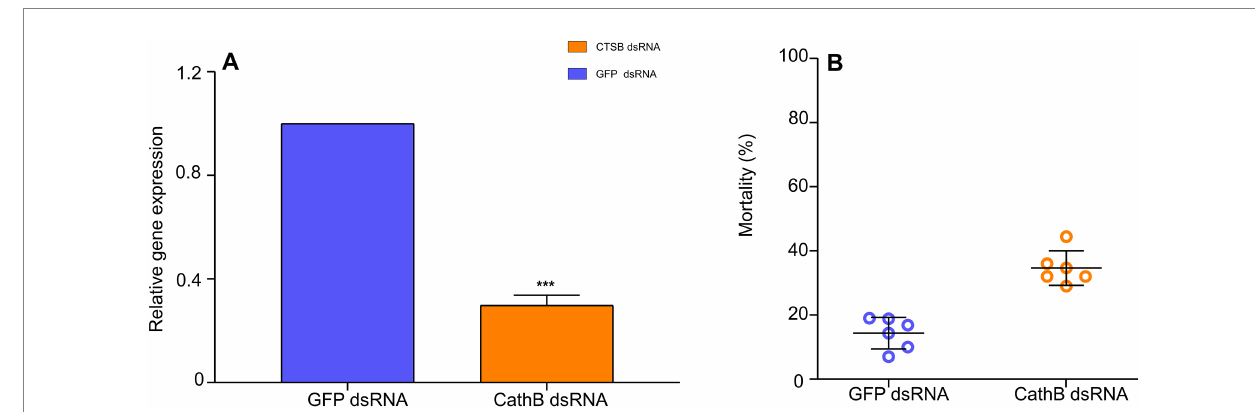
FIGURE 7 The effect of dsRNAs treatment on B. tabaci MED. (A) The relative gene expression of cathepsin B on B. tabaci MED of dsRNAs treatment. (B) The mortality effect on B. tabaci MED of dsRNAs treatment. GFP dsRNA, control group; CathB dsRNA, treatment group. In (A) , data are denoted as mean ± SE. *** indicates a significant difference at p <